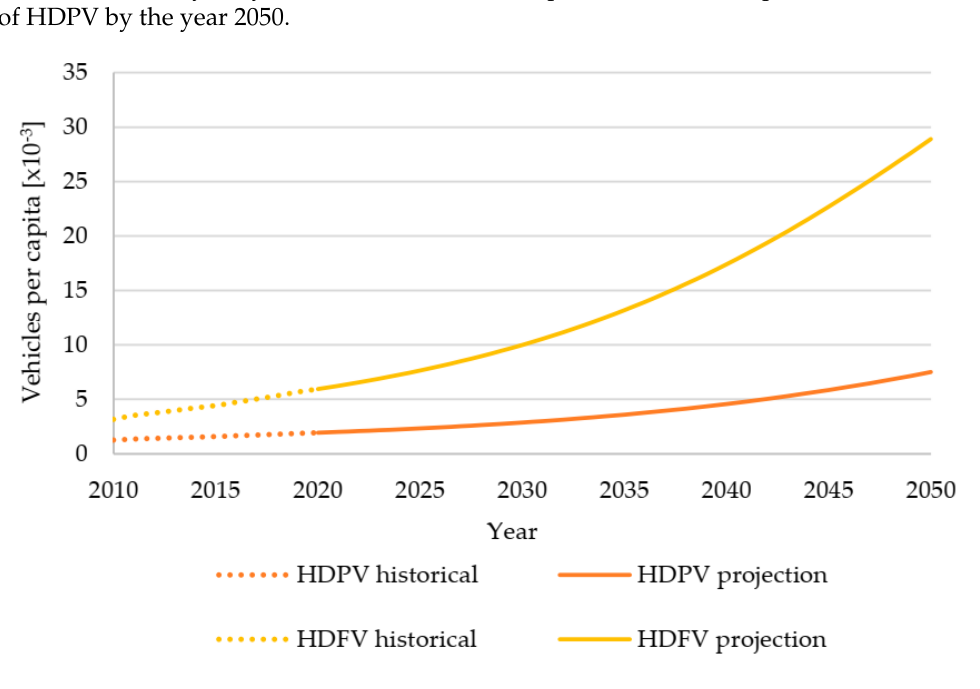
Figure 1. Projection of HDPV and HDFV per 1000 inhabitants by